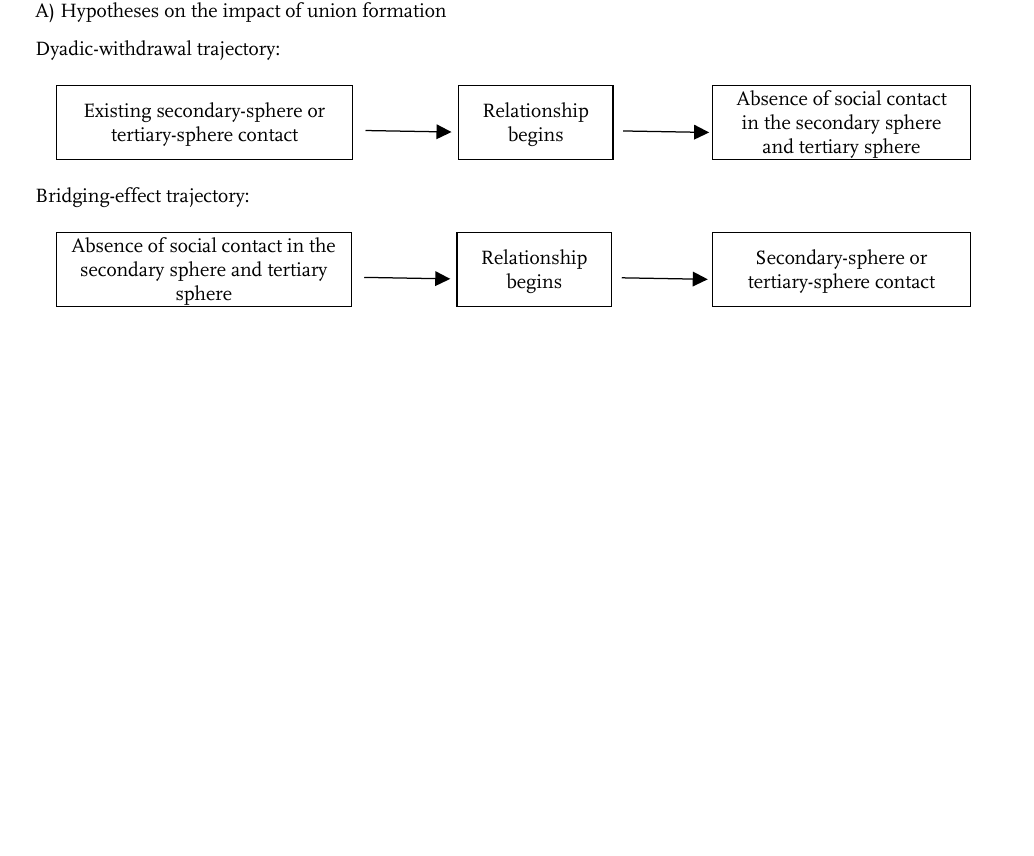
Figure 1 : Schematic representation of